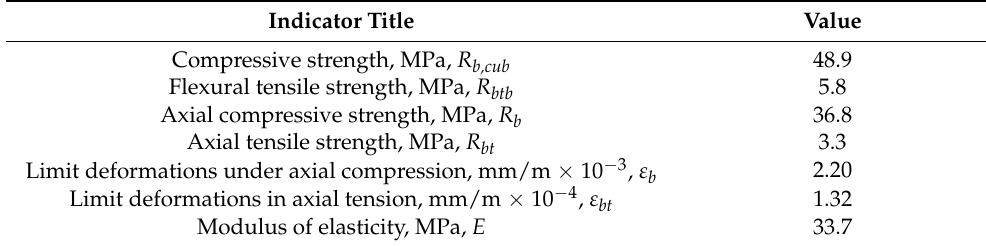
Table 10. Strength and deformation characteristics of concrete samples of the control composition. Indicator